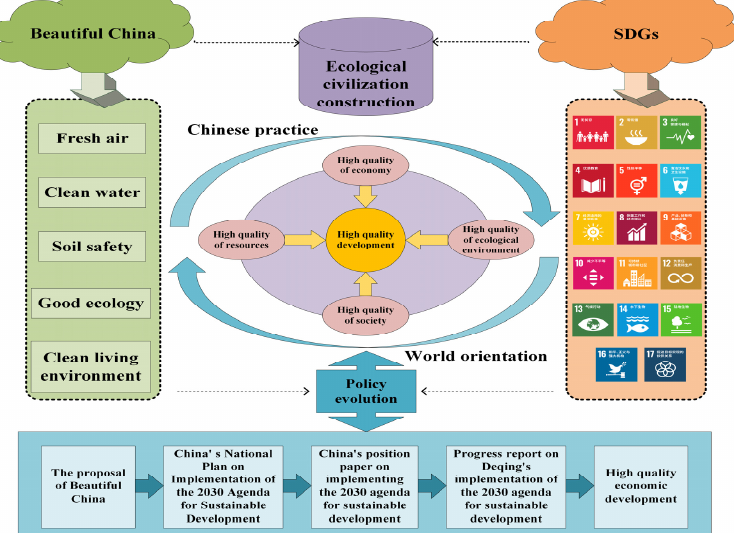
Figure 2. Evolution map of Beautiful China, SDGs, and high-quality development. 1 No Poverty; 2 Zero Hunger; 3 Good Health and Well-being; 4 Quality Education; 5 Gender Equality; 6